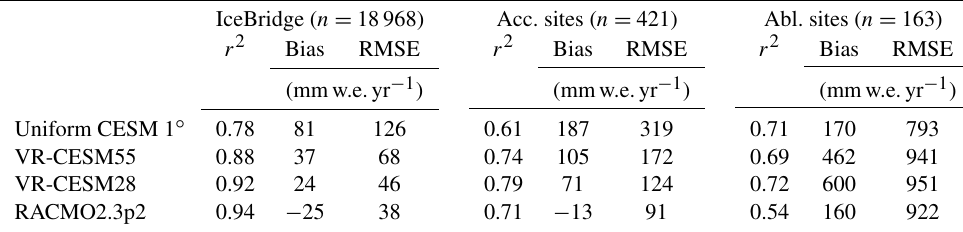
Figure 6. Point-by-point SMB differences between model and reference observations. Shading indicates the distribution, and horizontal line segments indicate maximum, median, and minimum values. Model climatologies have been computed over the period 1980–1999. Table 1. Selected statistics of CESM climatological SMB (downscaled to 4km) and RACMO2 climatological SMB (downscaled to 1km) with respect to IceBridge radar data, accumulation zone sites, and ablation zone sites. Shown are mean bias, coefficient of determination, and root-mean-square error. Model climatologies have been computed over the period 1980–1999, which does not necessarily overlap with the date of each